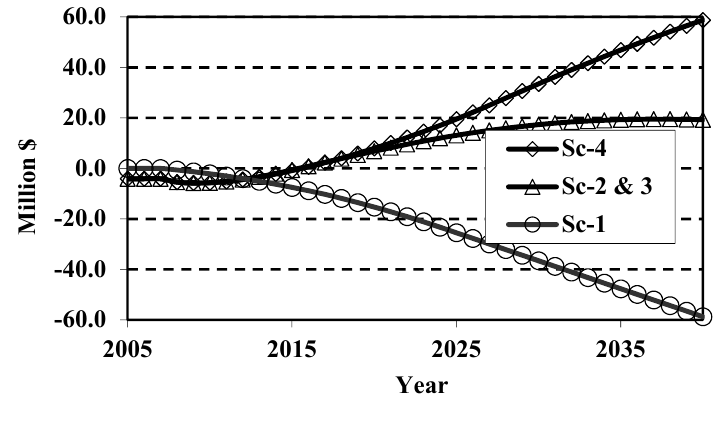
Figure 7. Net benefit analysis for the four MAR